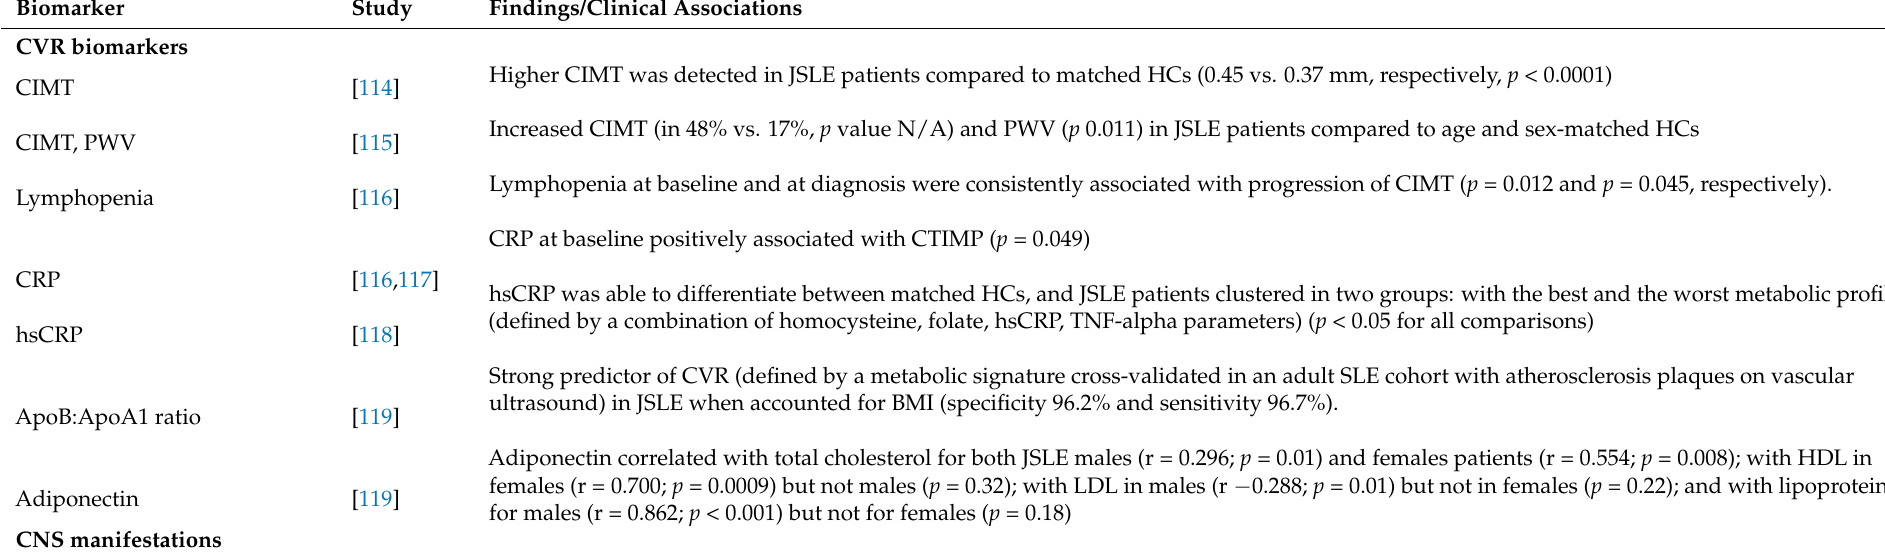
anticoagulant was more frequent in children without NPSLE (53.8 vs. 34.7%) (but p > 0.05) Significant positive association between anti-ganglioside M1 seropositivity and cognitive dysfunction ( p < 0.001), as well as with a significant risk for association with cognitive dysfunction (odds ratio: 36; 95% CI: 4.3–302.8) Increased likelihood to experience neurological symptoms ( p 0.002) and to have received anti-epileptic ( p = 0.023) and anti-coagulant ( p = 0.007) Predicted a group of JSLE patients (clustered based on the analysis of the most common autoantibodies found in JSLE in general) with highest prevalence of neuropsychiatric disease ( p =